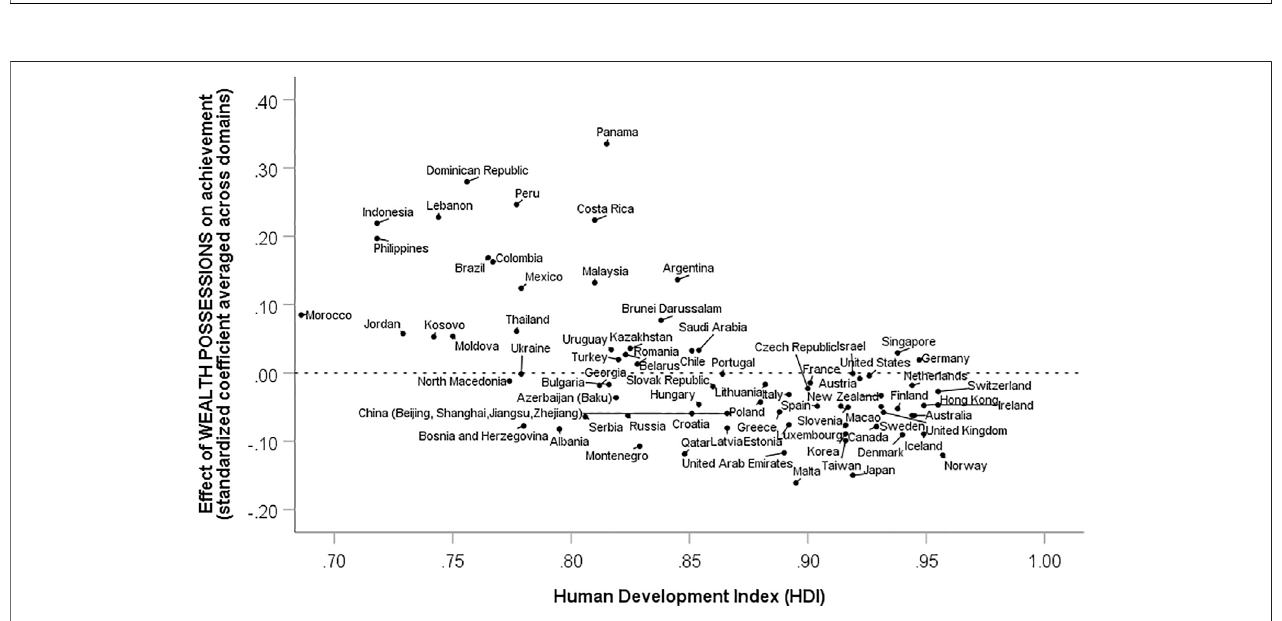
FIGURE 4 | Societies ’ HDI plotted against the independent effect of wealth possessions on achievement as measured by standardized coef fi cients averaged across the domains of math, science, and reading.